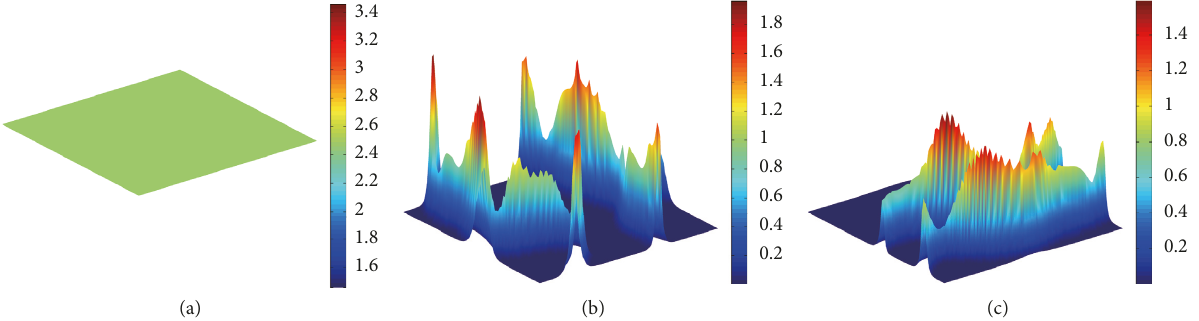
Figure 6: Spatial distribution of phytoplankton population under different diffusion parameters. Parameter values: I � 1 . 6, a � 0 . 5, b � 0 . 8, α � 0 . 7, m � 0 . 45, e � 0 . 2, h � 1, q � 0 . 01, ε � 0 . 001, τ � 0, and t � 500. (a) d � 0 . d 2